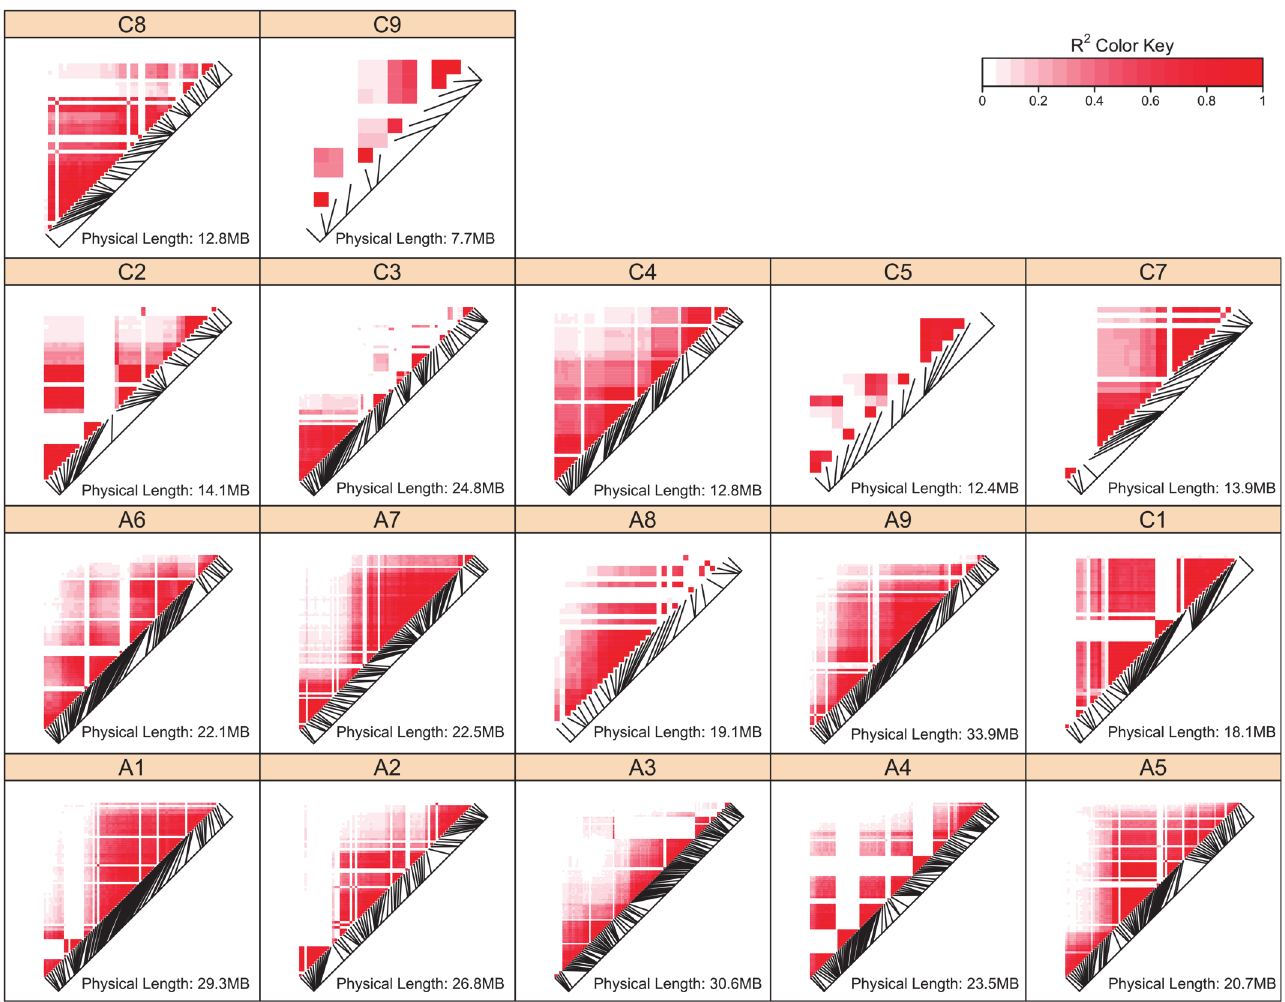
Fig 2. Pairwise linkage disequilibrium (r2) of genomic markers in each chromosome.